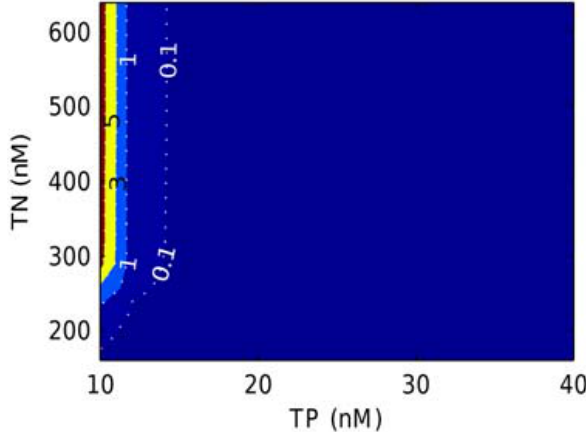
Fig.7:DissolvedorganiccarbonconcentrationsinµMafter100daysofsimulationasafunctionofTNandTP. Fig. 8. Dissolved organic carbon concentrations in µM after 100 days of simulation as a function of TN and